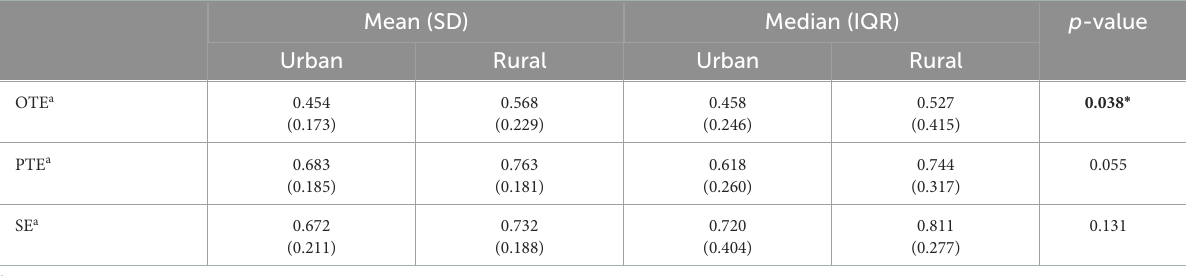
TABLE 6 OTE, PTE, and SE by geographical area ( n = 76).